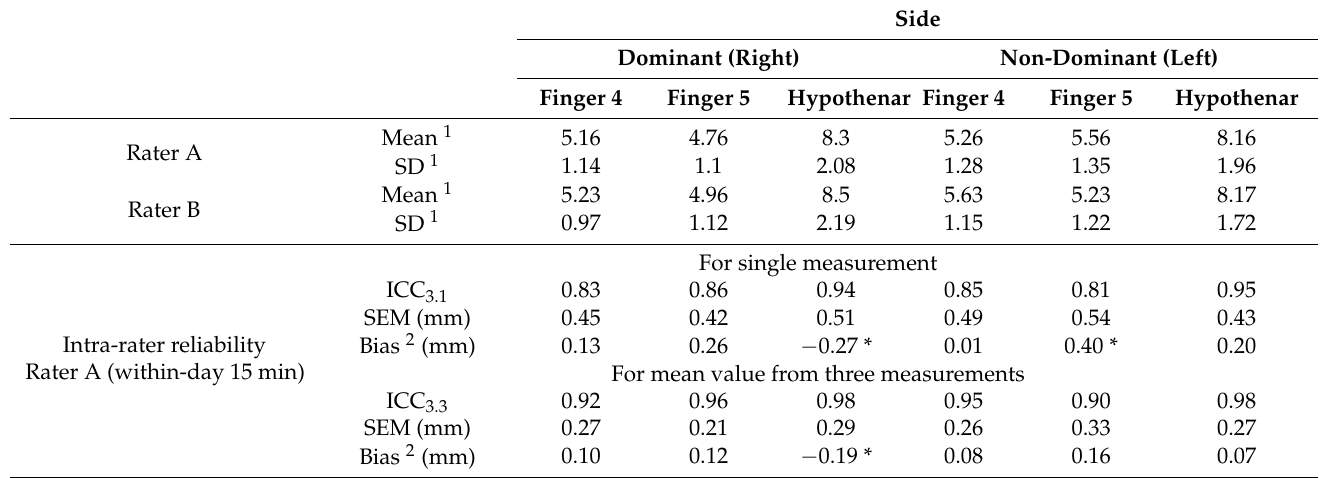
Table 5. Reliability and validity of two-point discrimination (2PD) test—Healthy volunteers (n =